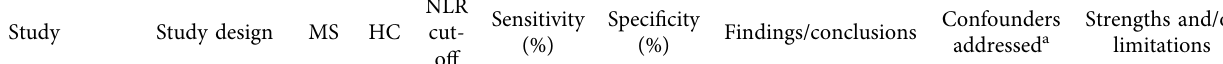
Table 1: Studies investigating the neutrophil-to-lymphocyte ratio NLR in patients with